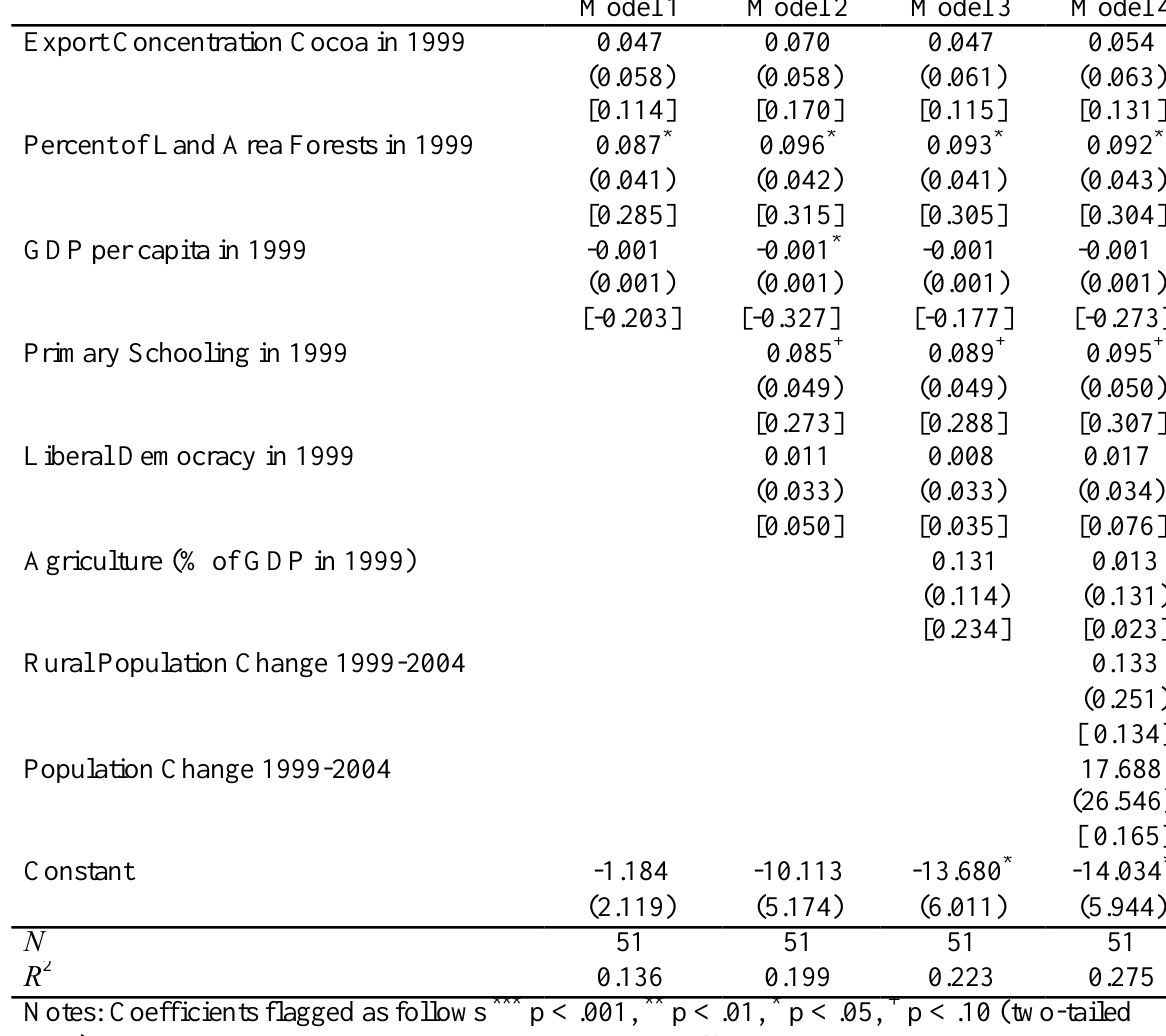
Table 7. OLS Regression Predicting Deforestation